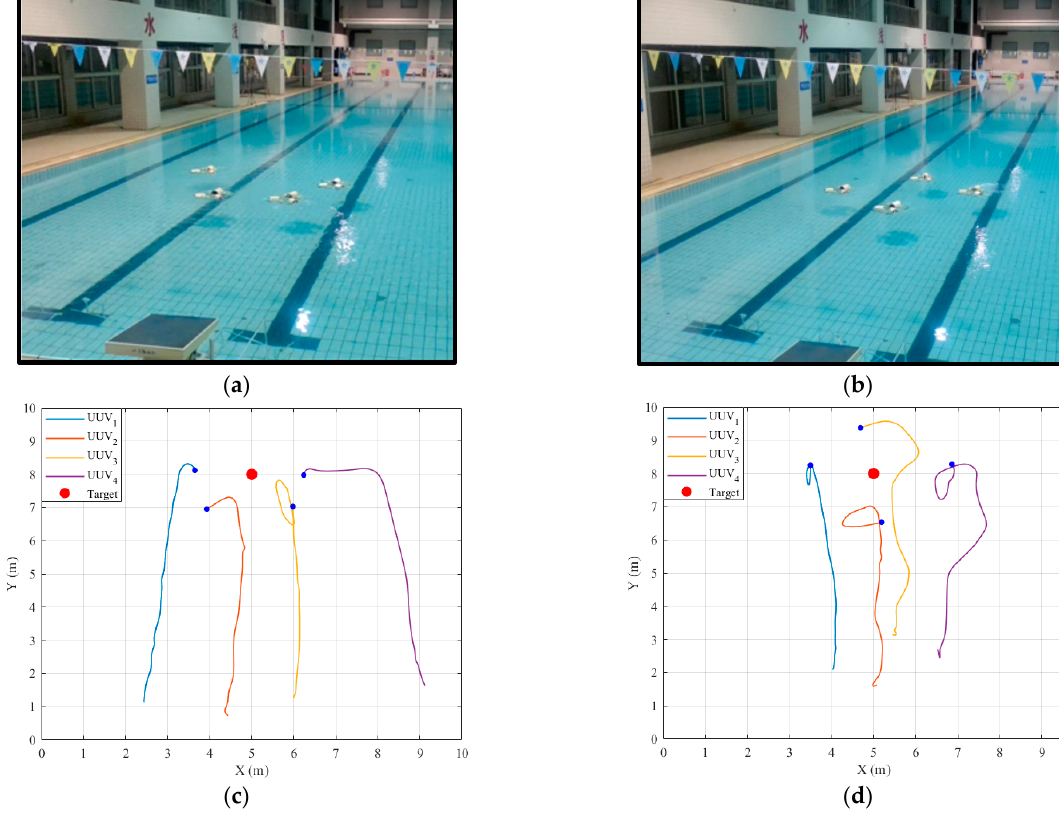
Figure 16. The results of the underwater experiment. ( a , b ) The running results of two experiments in the pool. ( c , d ) The UUV trajectories of the two